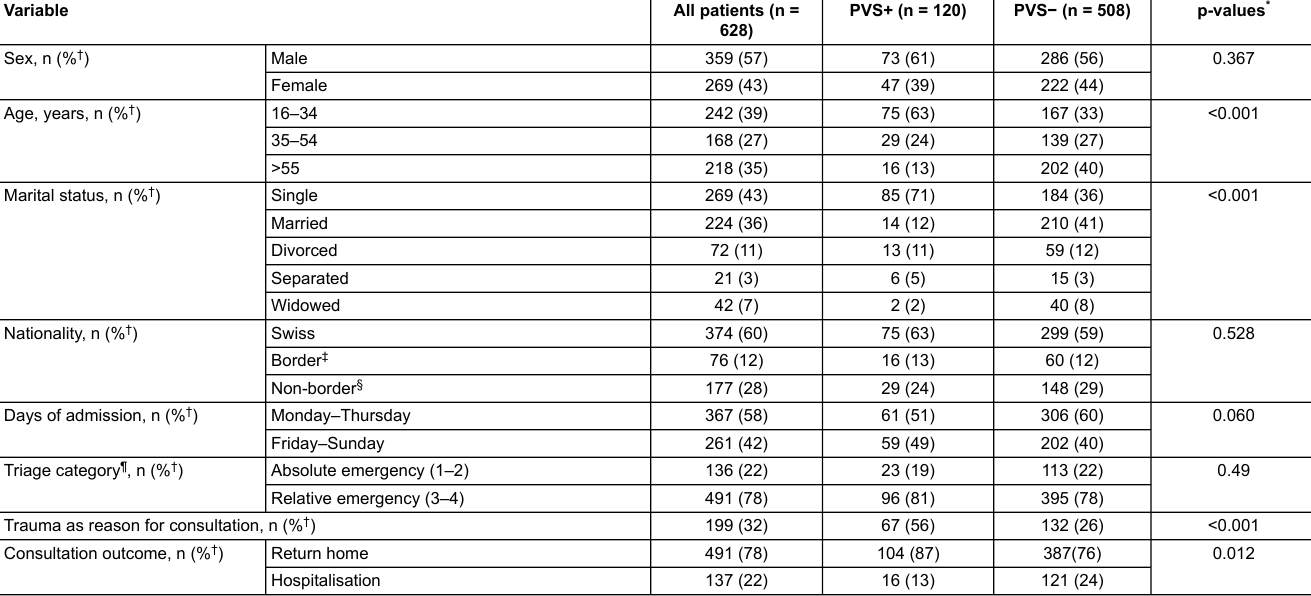
Table 1: Characteristics of patients who were and were not screened as victim of violence. Variable